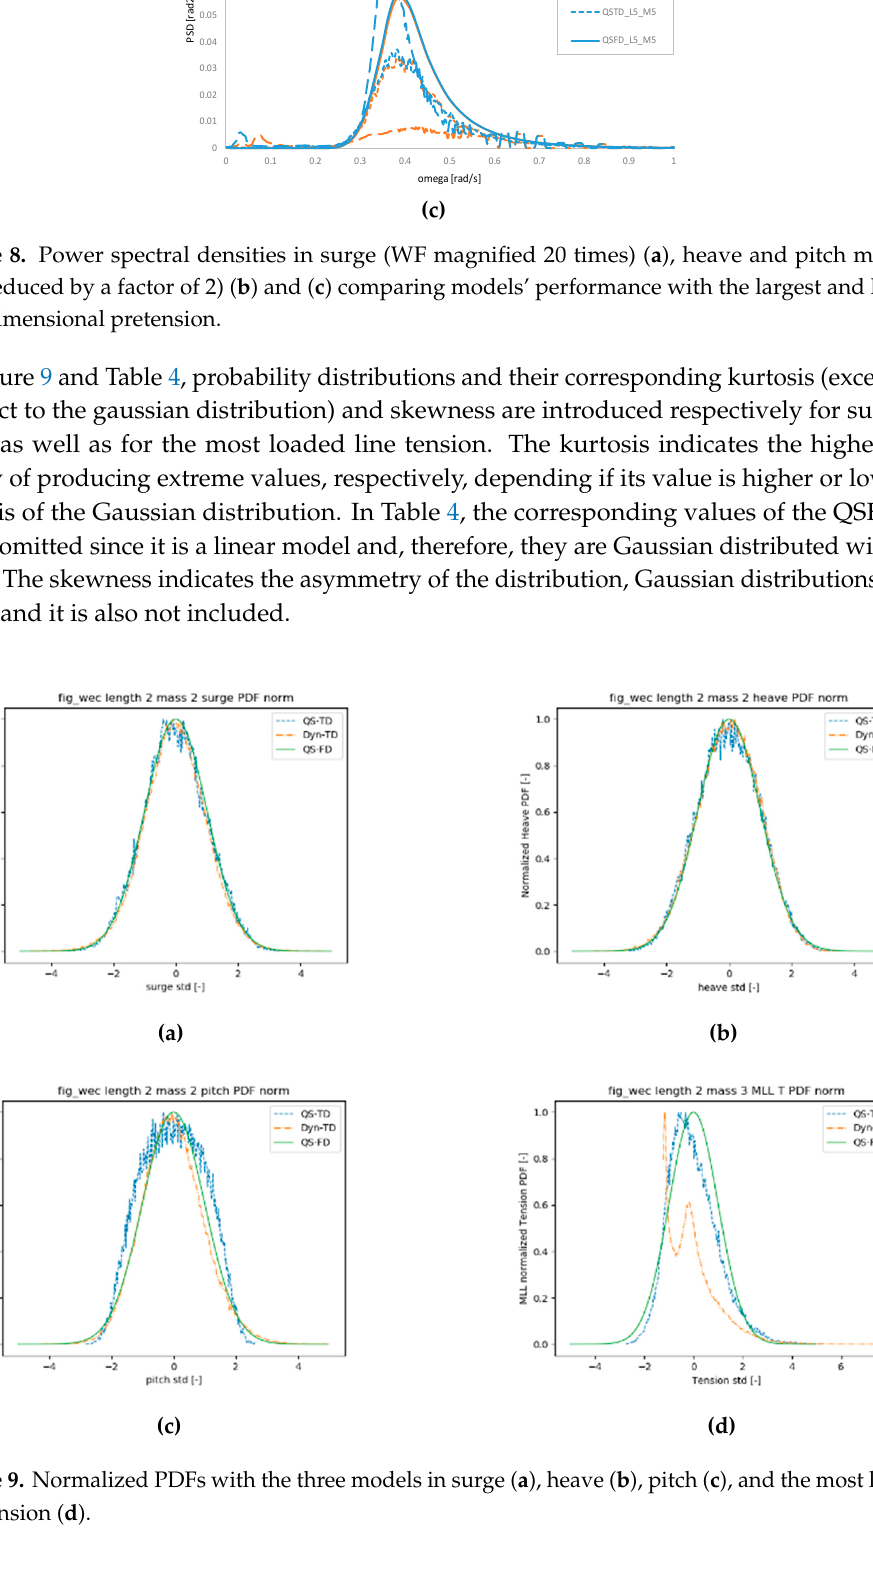
Figure 8. Power spectral densities in surge (WF magnified 20 times) (a), heave and pitch motions (WF reduced by a factor of 2) (b) and (c) comparing models’ performance with the largest and lowest non-dimensional pretension.